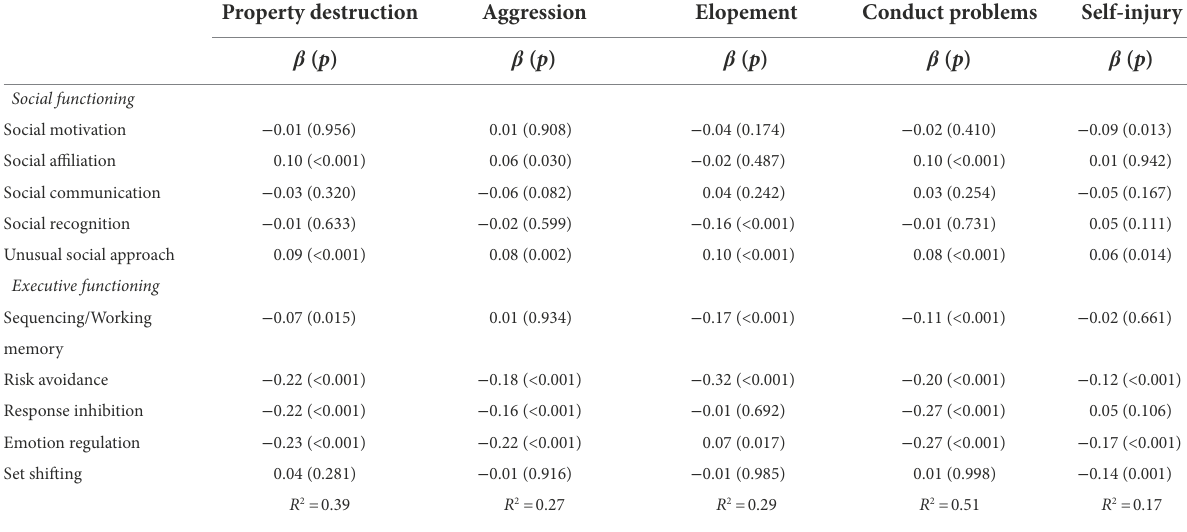
TABLE 1 Standardized path coefficients from executive and social functioning measures to challenging behavior